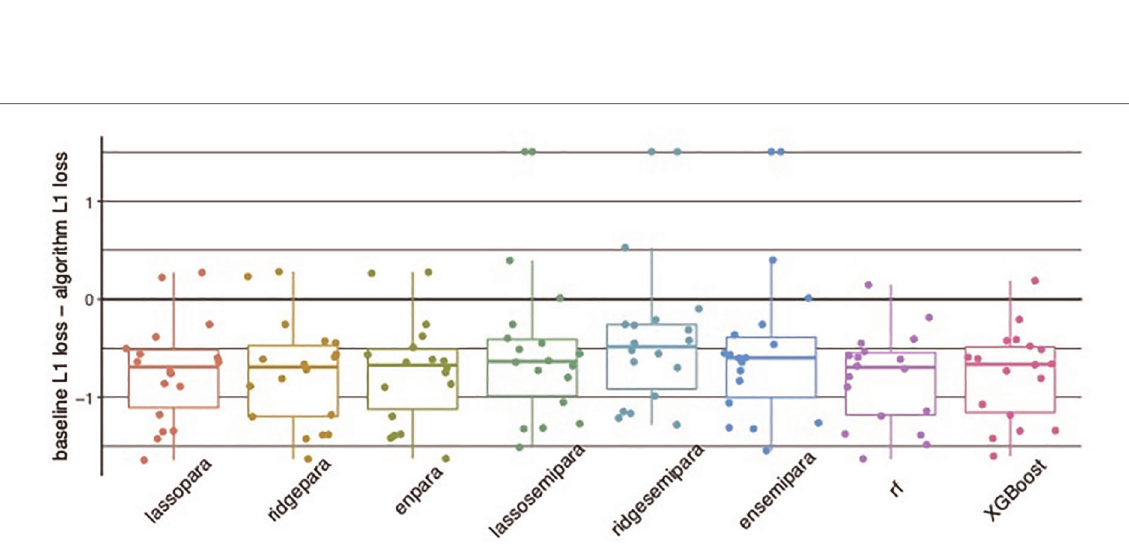
FIGURE 5 ( A ) Bar and whisker plot showing superior accuracy of tree-based algorithms, in random forest (rf) and XGBoost with controlled algorithm L1 loss compared to parallel and semi-parallel ordinal regression. ( B ) Bar graphs for individual Functional Independence Measure (FIM) items illustrating tree-based algorithms random forest (rf) and XGBoost with the lowest